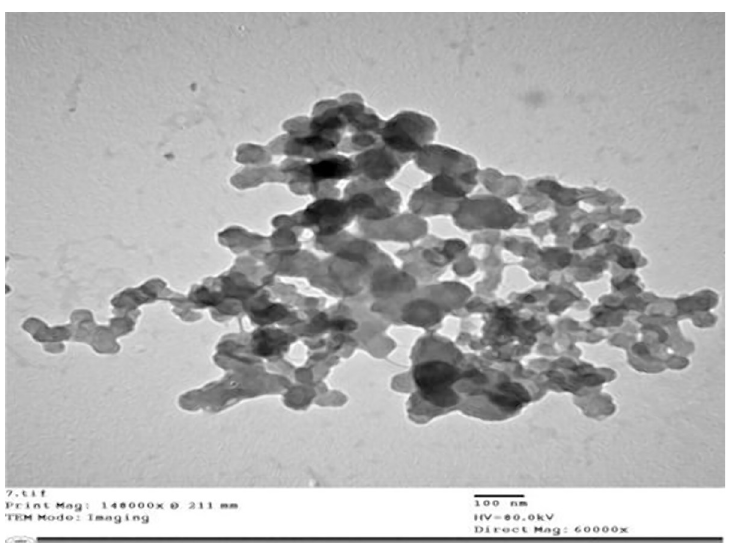
Fig 6. EM micrographs of the aggregated Cu–chitosan nanoparticles